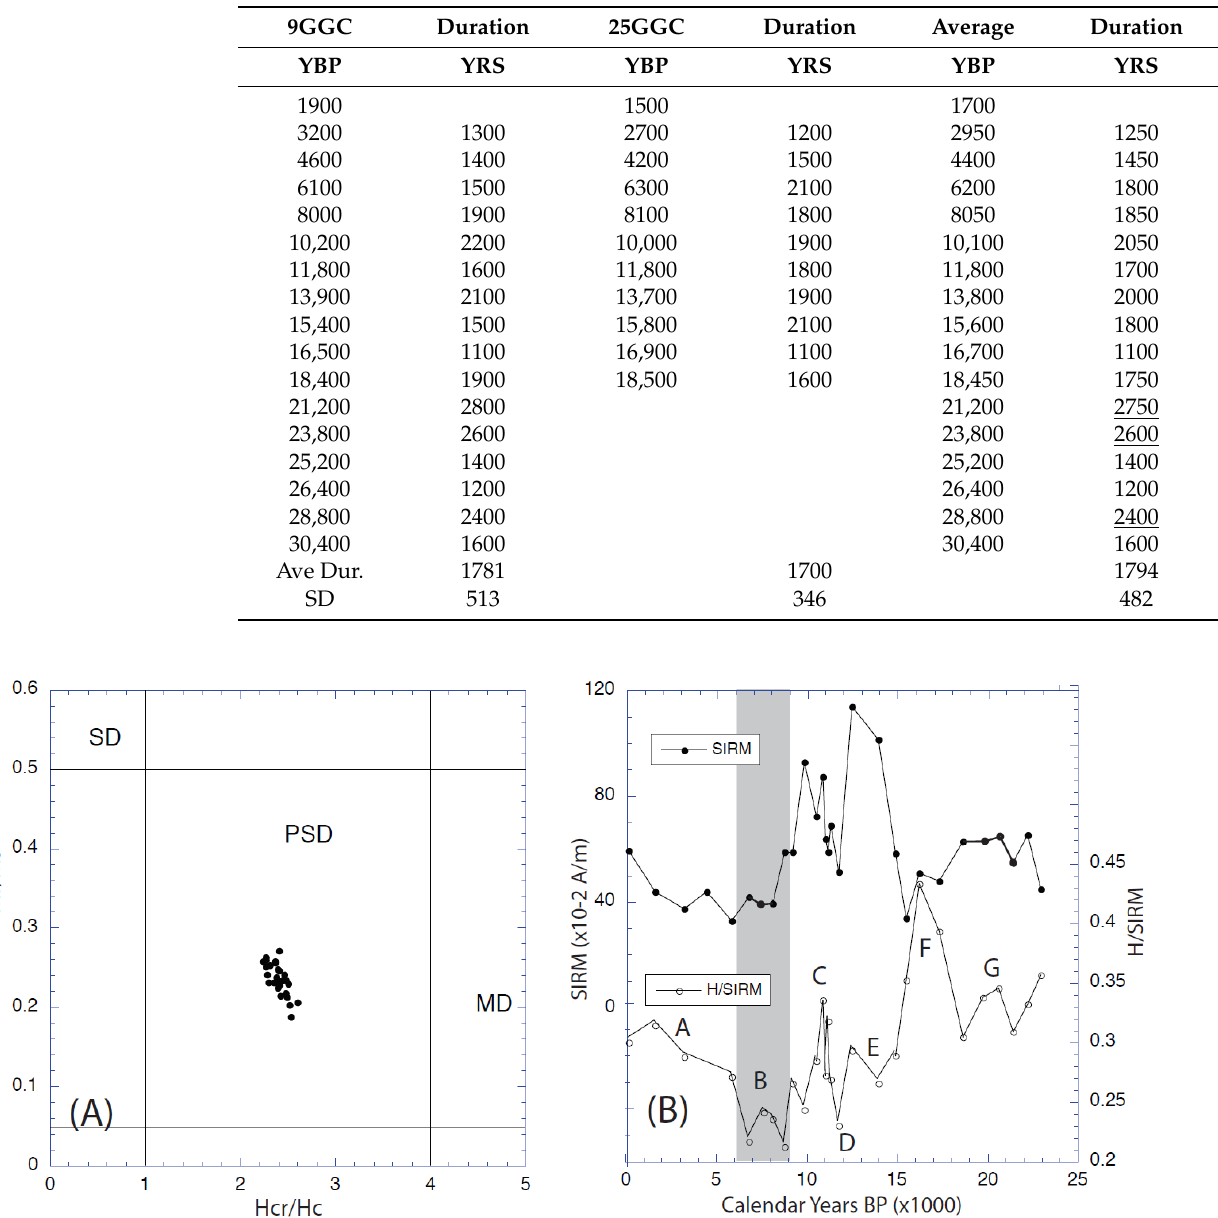
Table 2. Timing of millennial-scale intensity peaks and durations between successive intensity peaks.